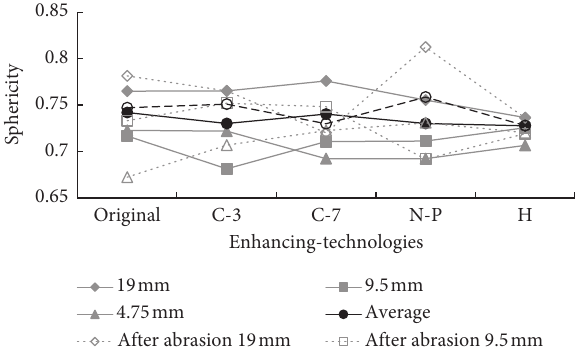
Figure 10: Sphericity of RA before and after chemical enhancing- technology.